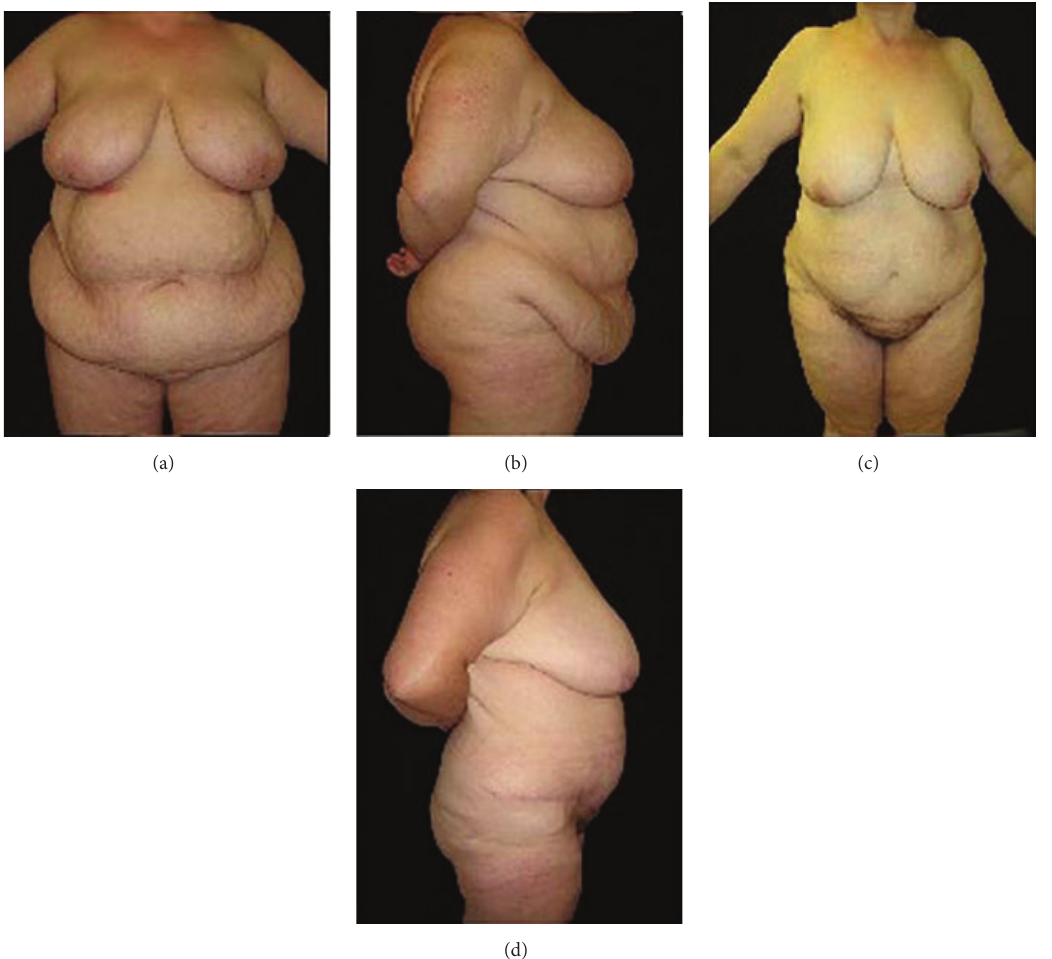
Figure 6: (a) Preoperative frontal view and (b) lateral view of a female patient (BMI = 46 kg/m 2 ; body weight = 129kg). (c) Postoperative frontal view and (d) lateral view five years after surgery (body weight = 82 kg).